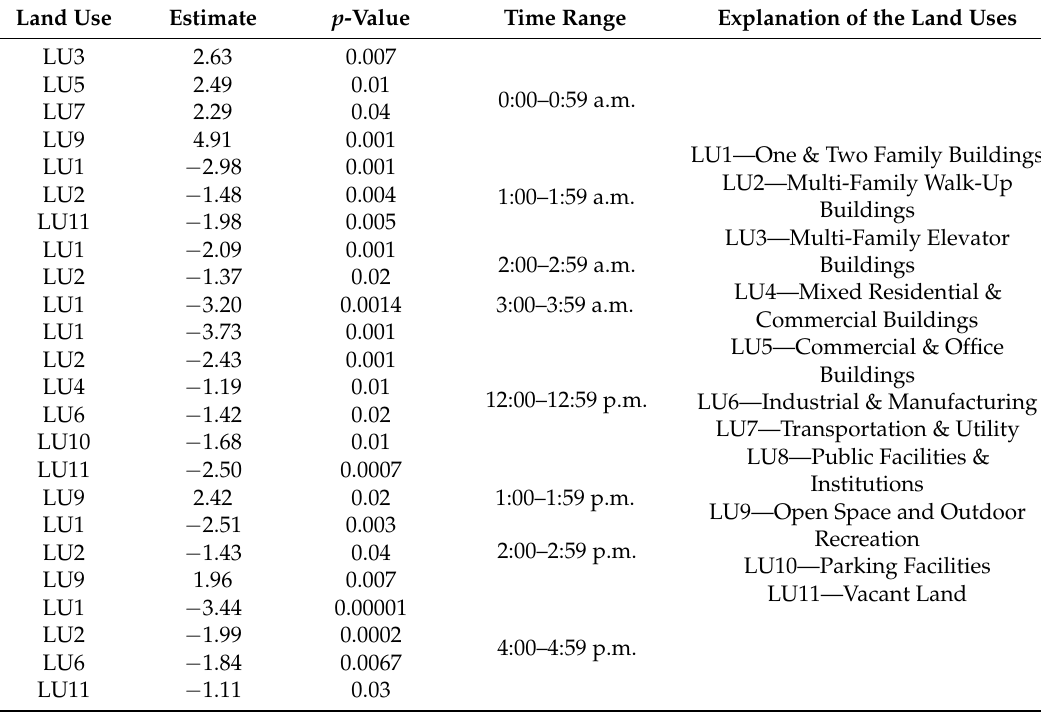
Table 5. Prediction models for different time